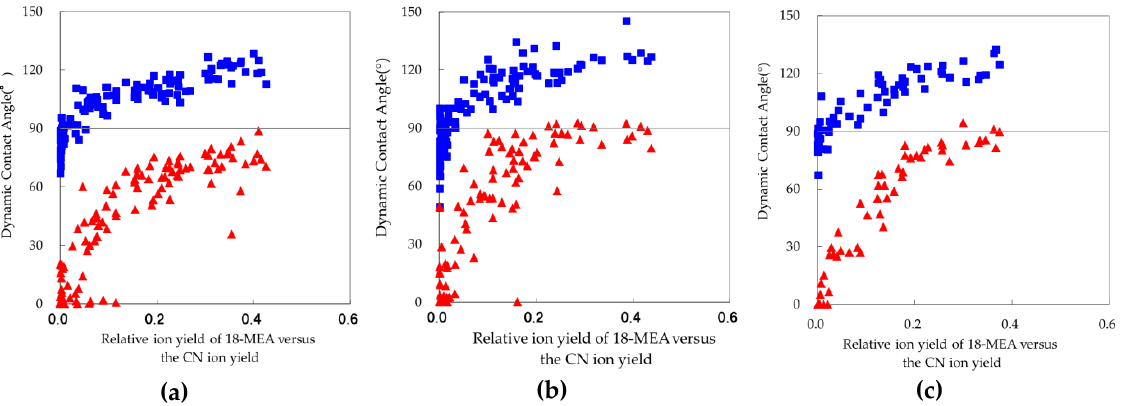
Figure 2. Relationship between dynamic contact angles (advancing and receding) and the semi-quantitative amount of 18-MEA on the outermost surface of ( a ) Chinese, ( b ) Blonde, and ( c ) Brunette female hair measured by TOF-SIMS. Same procedure as Japanese hair was adapted to analyze these hair fibers.